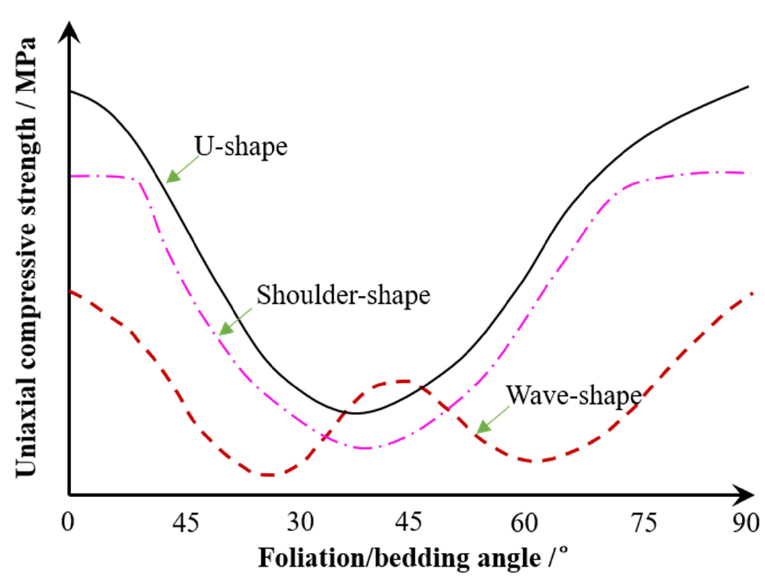
Figure 18. Uniaxial compressive strength of anisotropic rock versus foliation or bedding angle.